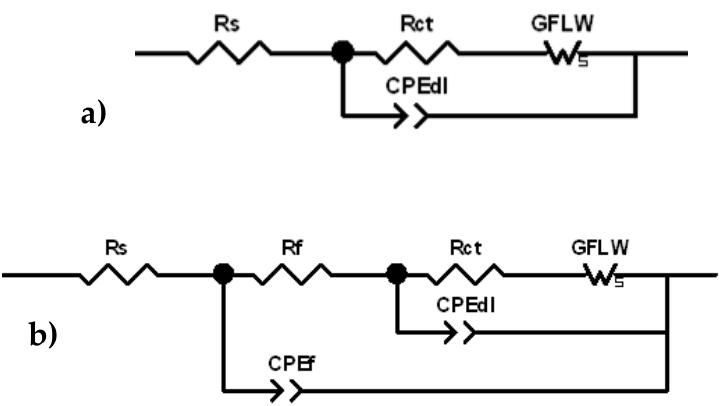
Figure 7. Equivalent circuits (EC) used to fit the electrochemical impedance spectroscopy (EIS) spectra: ( a ) two-time-constant EC; ( b ) three-time-constant EC.